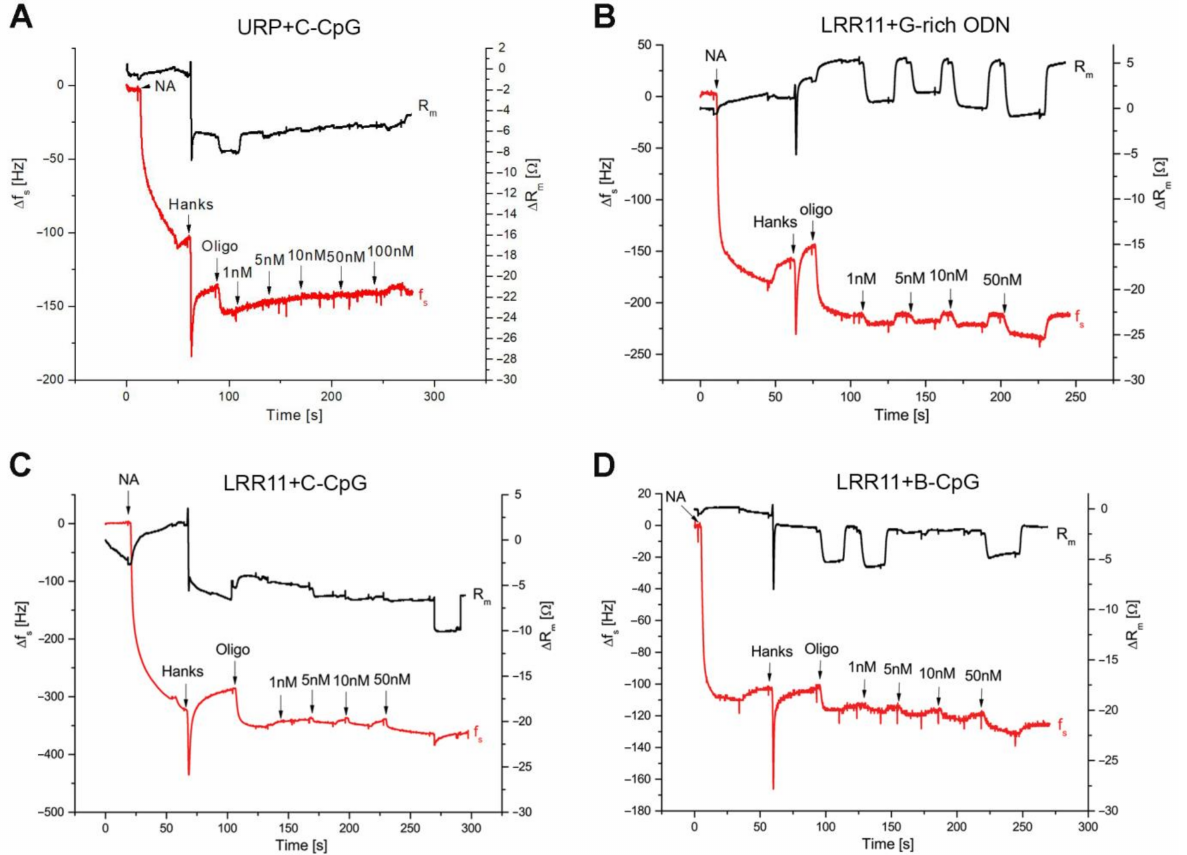
Figure 4. The representative kinetic curves of the resonance frequency ( ∆ f s , red) and the motional resistance ( ∆ R m , black) changes that occurred after adding peptide: URP ( A ) or LRR11( B – D ) at different concentrations (nM), to the surface of a TSM transducer modified by NeutrAvidine with attached 5 (cid:48) -biotinylated ODNs. Peptide additions are indicated by arrows. Hanks buffer solution was used to replace media after NeutrAvidine immobilization on a TSM transducer.